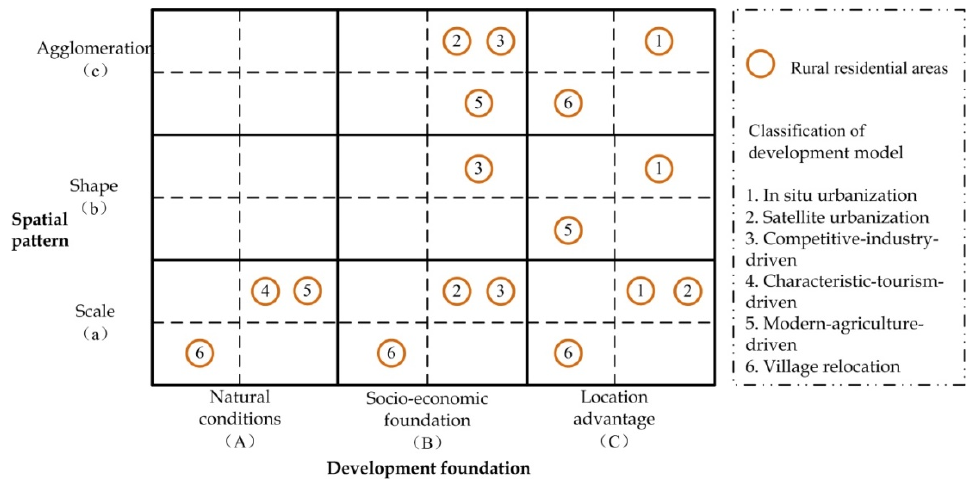
Figure 3. The basis for the classification of development models of rural settlements.